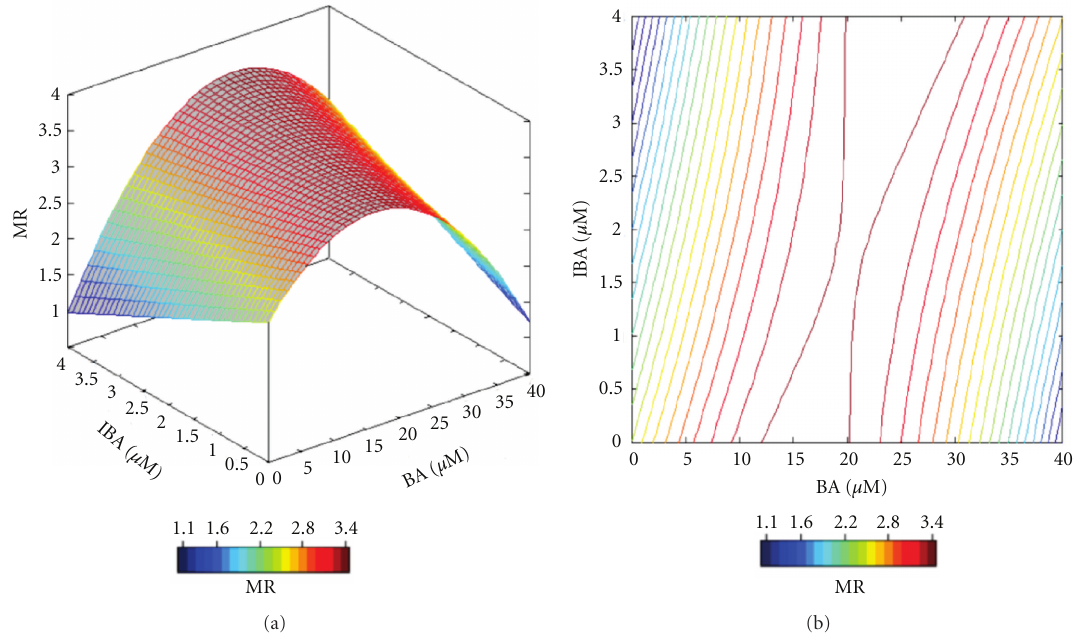
Figure 2: Response surface plot of Handroanthus impetiginosus multiplication rate as a function of benzyladenine (BA) and indole but-yric acid (IBA) concentration on Woody Plant Medium [10] after 30-day culture. (a) 3D response surface graph; (b) contour plot of multipli- cation rate.